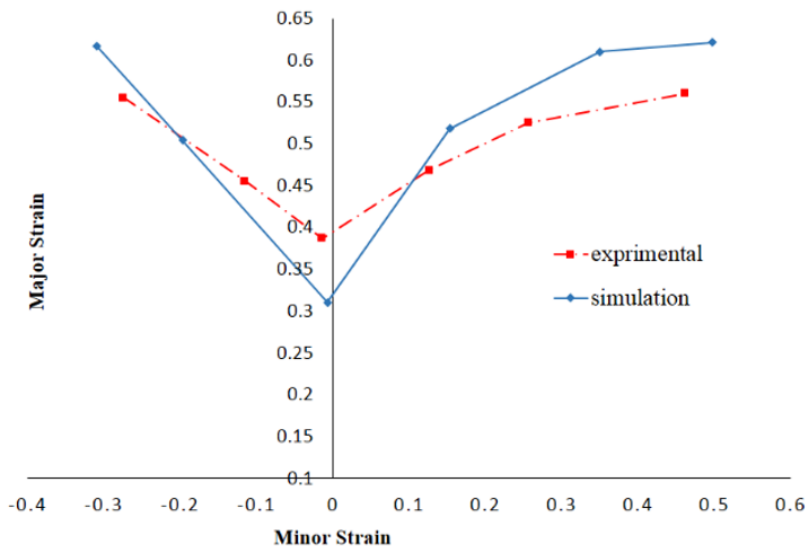
Figure 11. Comparing the experimental and simulated FLDs for a 3 mm-thick AA 6061 sheet at 100 mm/min speed.